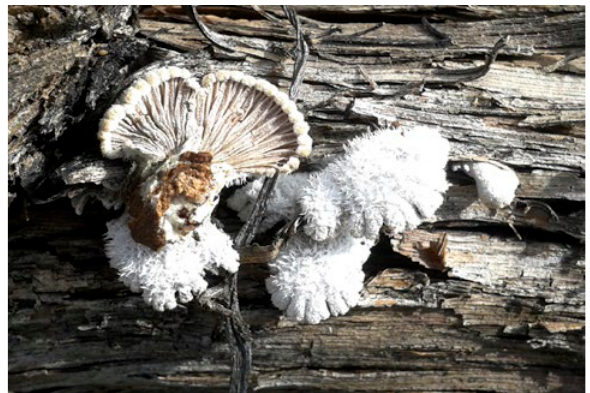
Figure 8. Multipileate basidiocarps of Schizophyllum commune growing on grapevine bark. Photograph: V.